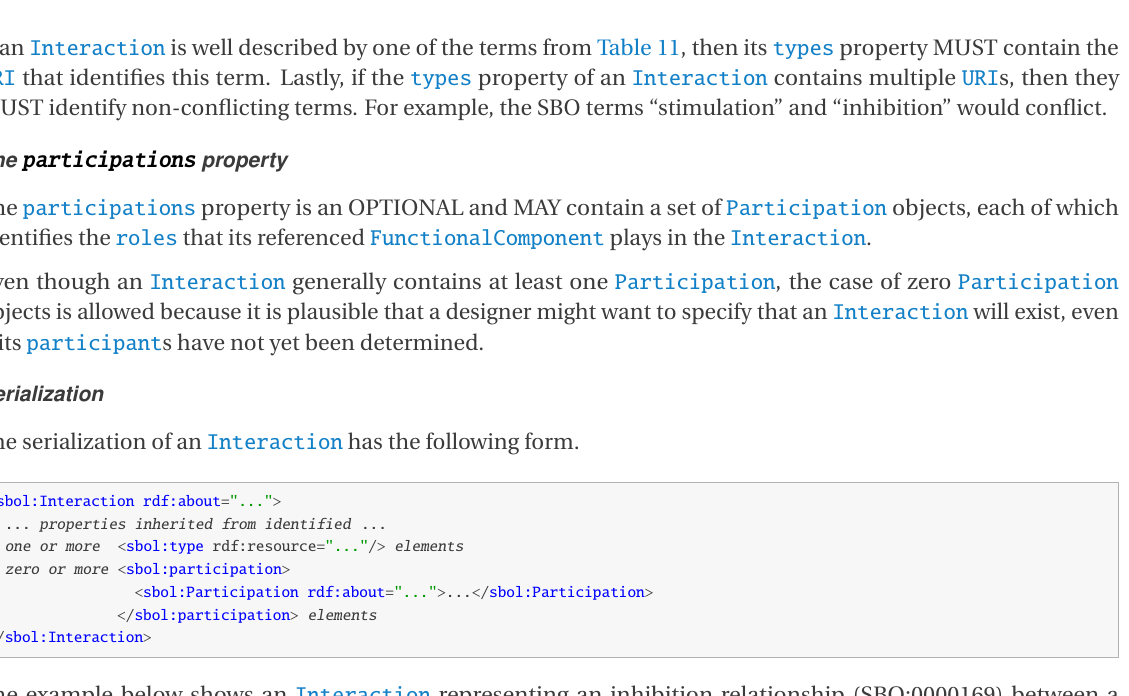
Table 11: SBO terms to specify the types property of an Interaction